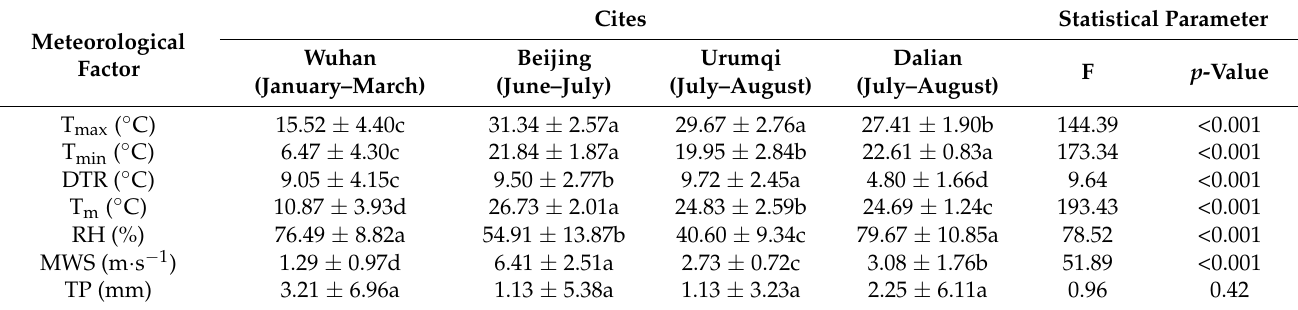
Table 5. Differences in meteorological factors between four cities during the period of community-based epidemic prevention and control, which was tested using one-way ANOVA. Definitions of T max , T min , DTR, T m , RH, MWS and TP are presented in Figure 1. The different lowercase letters after the Mean values indicate a significant difference ( p < 0.05) in meteorological factors among the four cities, whereas same lowercase letters show no significant differences ( p > 0.05). Meteorological